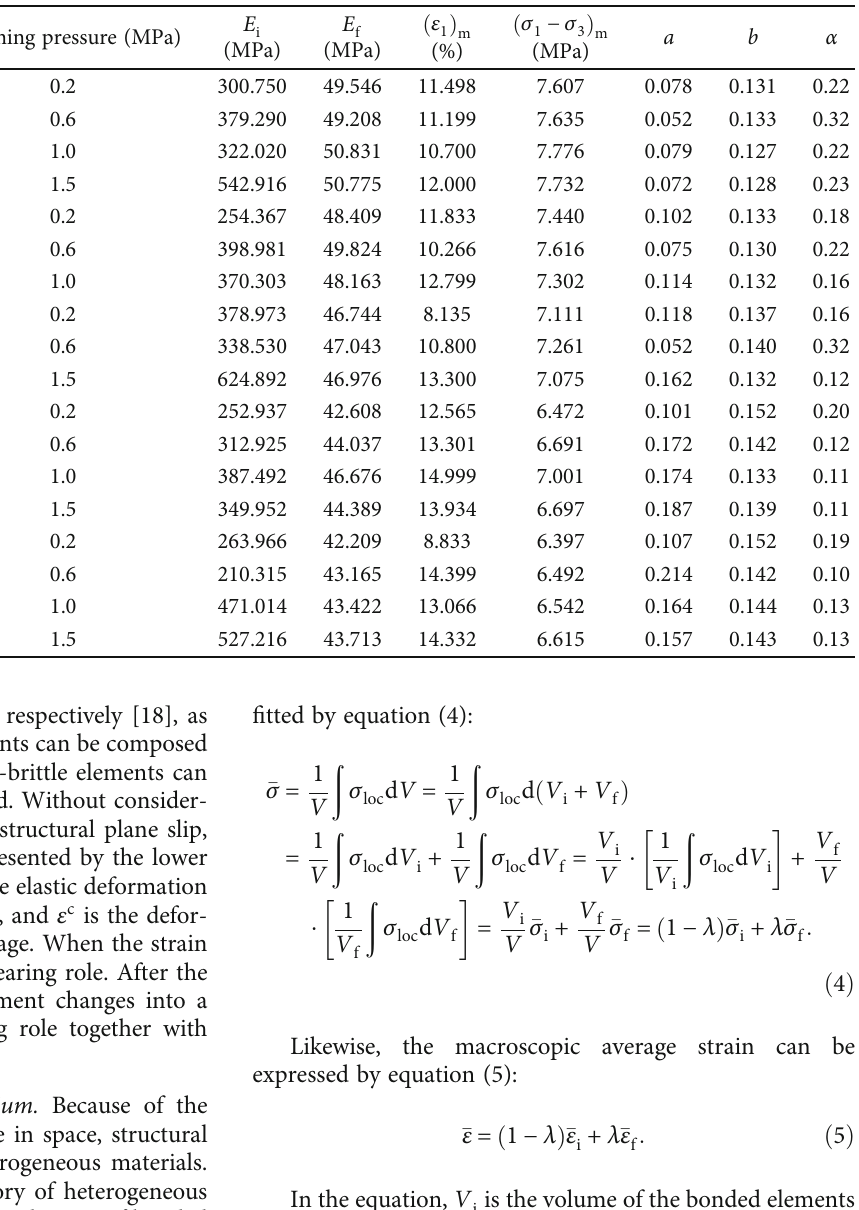
Table 3: Parameters of binary medium simpli fi ed model of frozen silty